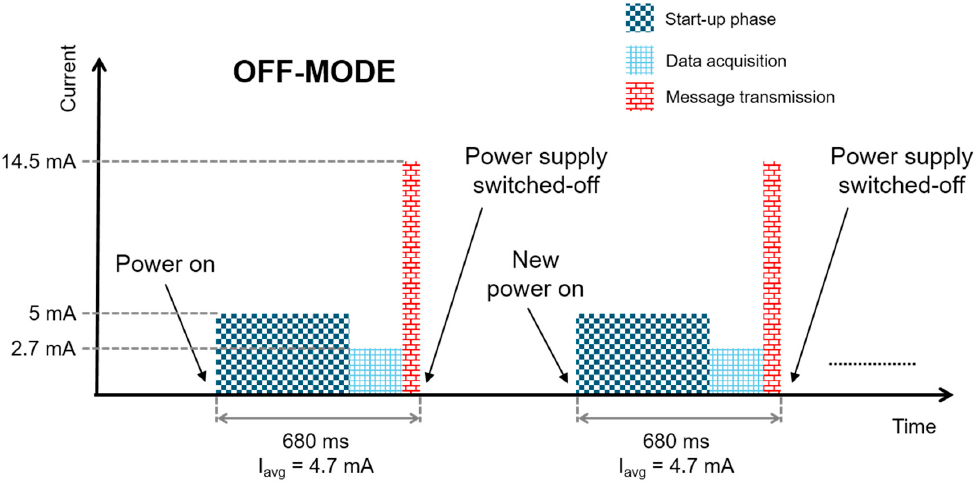
Figure 10. Schematic, not to scale, of the node current consumption in off-mode; the average charge consumption in each activation phase is Q = I ∗ T = 4.7 mA ∗ 680 ms = 3.196 mC.